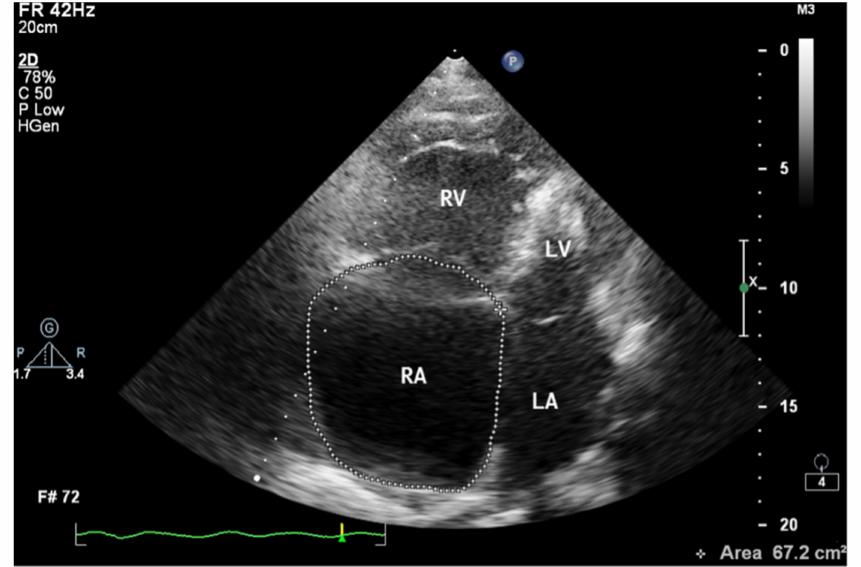
Figure 7. Enlarged right atrium with an area of 67.2 cm 2 . 2D-TTE, 4CH view. 2D-TTE: two- dimensional transthoracic echocardiography; 4CH: